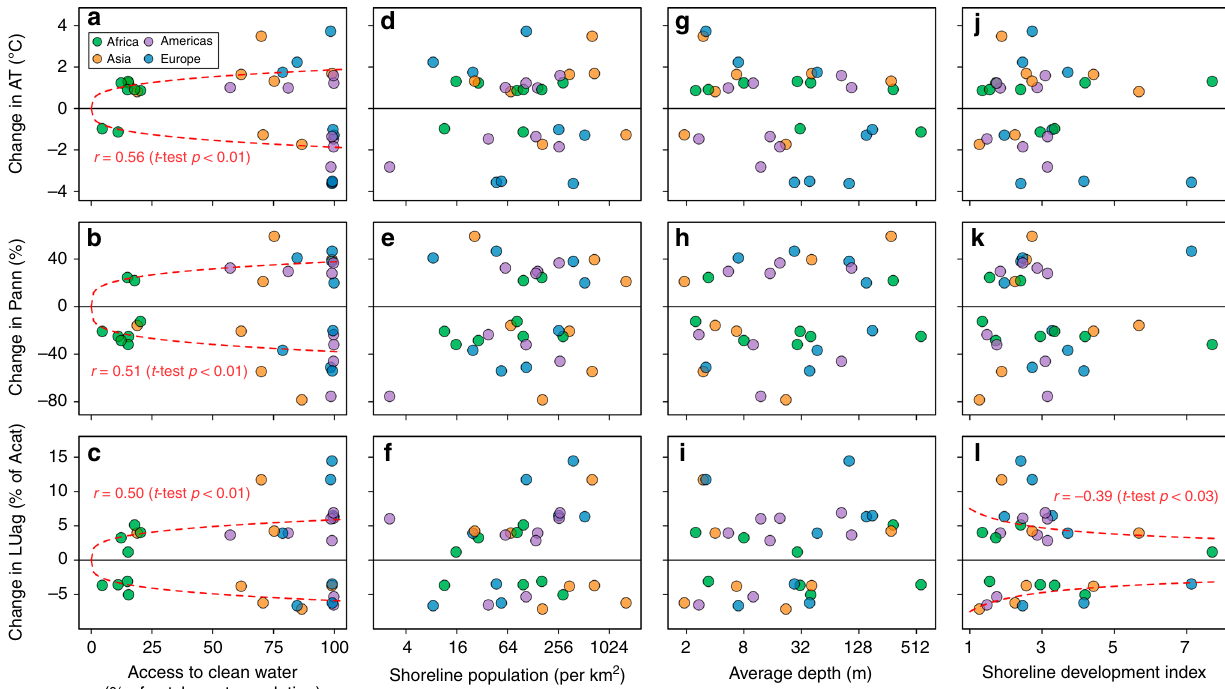
Fig. 7 Identi fi cation of the characteristics of the vulnerable lakes. The fi gure shows simulated median magnitudes of changes, from the 1970 – 2014 medians, for air temperature (AT), precipitation (PRE), and agricultural land use (LUag, in terms of percent of catchment area (Acat)) associated with a 25% decrease, also from the 1970 – 2014 medians, in fi sh catches and their associations with access to clean water ( a – c ), shoreline population density ( d – f ), average depth ( g – i ), and shoreline development index (SDI; j – l ) across the 31 study lakes. Note that points in the negative section have negative simulated median changes associated with a 25% decrease in fi sh catches. A lake with higher vulnerability of fi sh catches to climate and land-use changes is indicated by lower magnitudes of changes in AT, PRE, and LUag associated with a 25% decrease, from the 1970 – 2014 medians, in fi sh catches. A least- squares line is added when the correlation is signi fi cant at p = 0.05 level ( t test, N = 31). The access to clean water is measured by the proportion of population in the catchment using drinking-water and sanitation services. The shoreline population density is the population density within 10 km of a lake ’ s shoreline. SDI is a dimensionless index for circularity of the lake surface and a larger SDI indicates that the lake surface is less circular and may have a larger littoral area relative to lake area 24 . Source data for this fi gure are provided as a Source Data fi